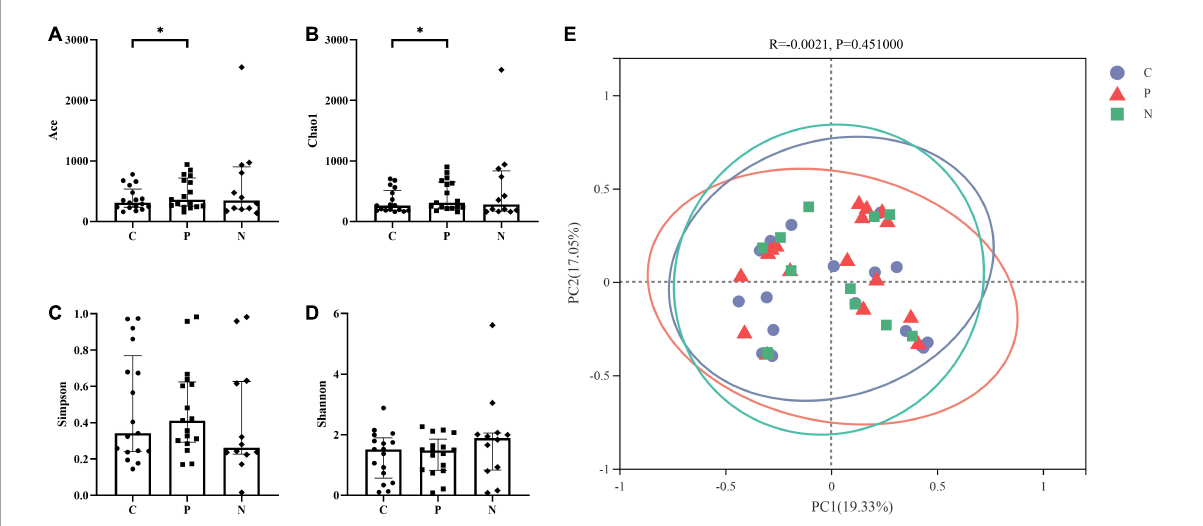
FIGURE2 Alpha and beta diversity among Groups C, P, and N. The Ace and Chao1 indices in Group C were higher than those in Group P ( P < 0.05), but there were no differences between Groups C and N or between Groups P and N ( P > 0.05). (A,B) The Simpson and Shannon indices showed no difference among Groups C, P and N ( P > 0.05). (C,D) There was no significant difference in the beta diversity among the three groups ( P > 0.05) (E)